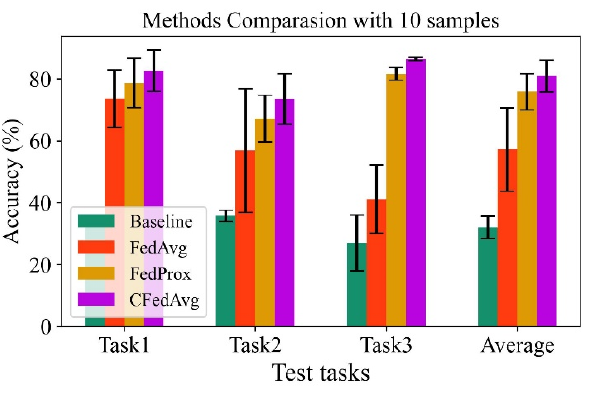
Figure 7. Comparison of federated methods in cross-working conditions.